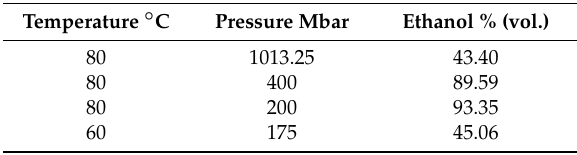
Table 1. Assays of simple batch distillation of fermented broth in a rotary evaporation system: different temperatures and vacuum levels combinations and % ethanol